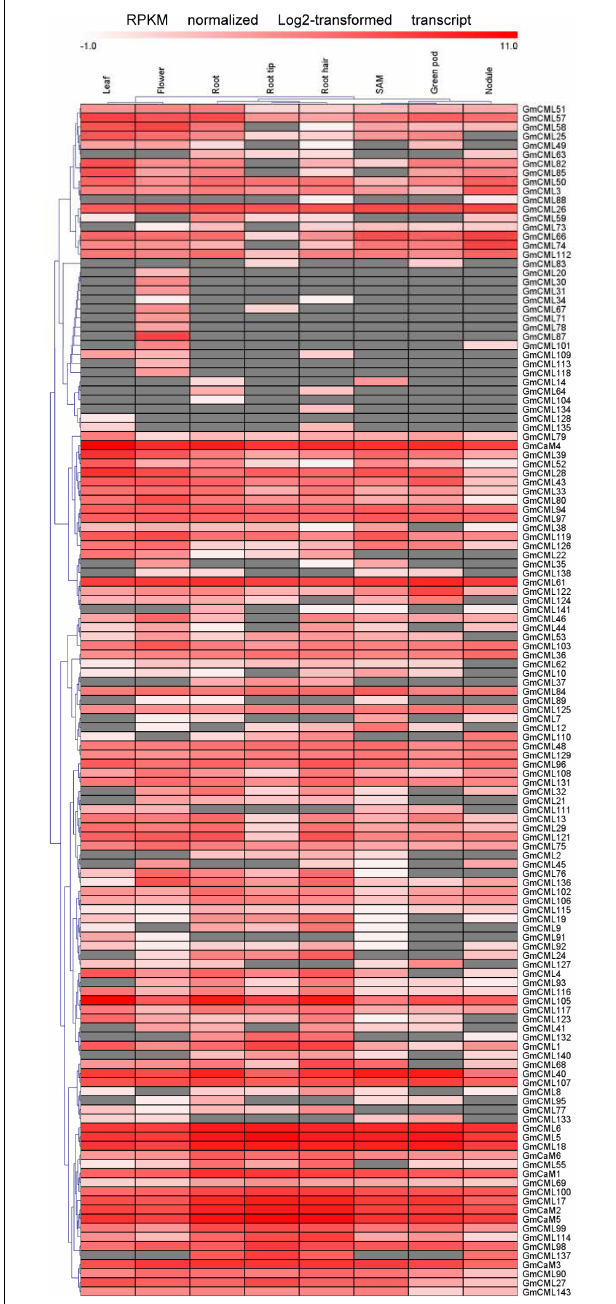
FIGURE 9 | Heat map representation for tissue-specific expression patterns of the predicted GmCaM/CML genes according to Illumina transcriptome data. The Reads/Kb/Million (RPKM) normalized log2 transformed counts were visualized in the heat map. The red colors indicate expression intensity, gray color indicates no expression.